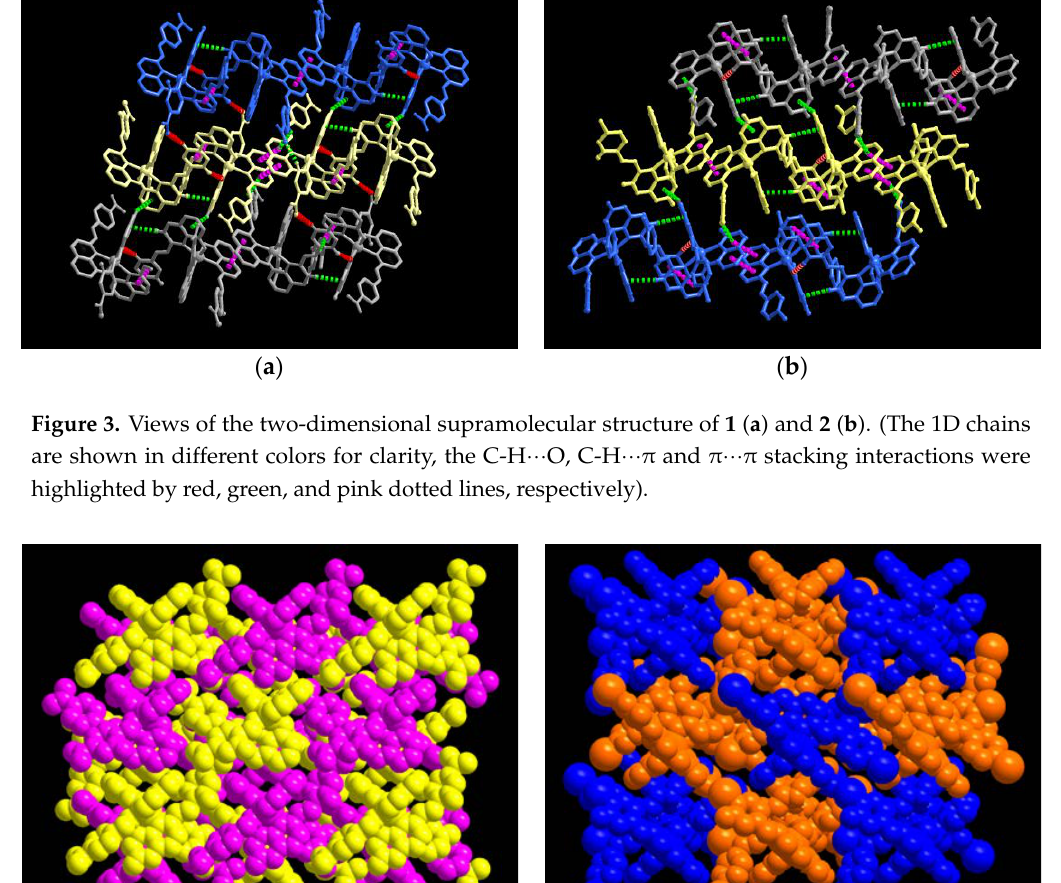
Figure 3. Views of the two-dimensional supramolecular structure of 1 ( a ) and 2 ( b ). (The 1D chains are shown in different colors for clarity, the C-H···O, C-H··· π and π ··· π stacking interactions were highlighted by red, green, and pink dotted lines, respectively).